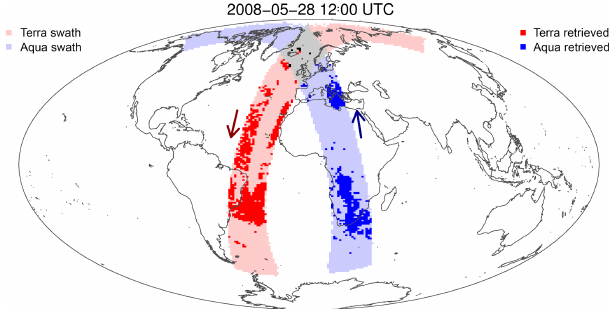
Figure 6. Map of hourly swath and retrieval aggregation during ± 30min of 12:00UTC on 28 May 2008. MODIS-T and MODIS-A swaths are in light red and blue shading, whereas retrieved pixels are a darker color. The arrows represent the direction of the satellite orbit across the equator (descending for Terra, ascending for